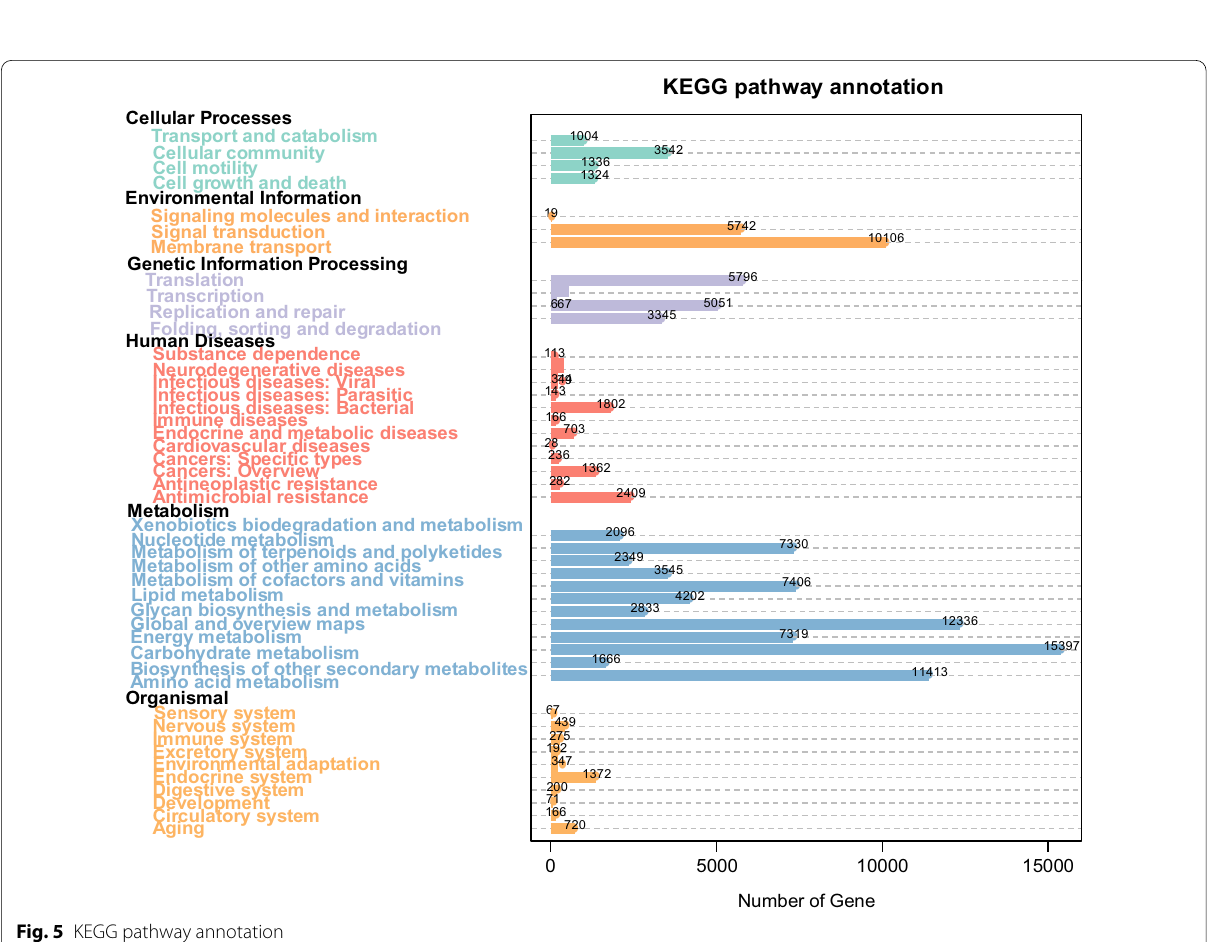
Fig. 5 KEGG pathway